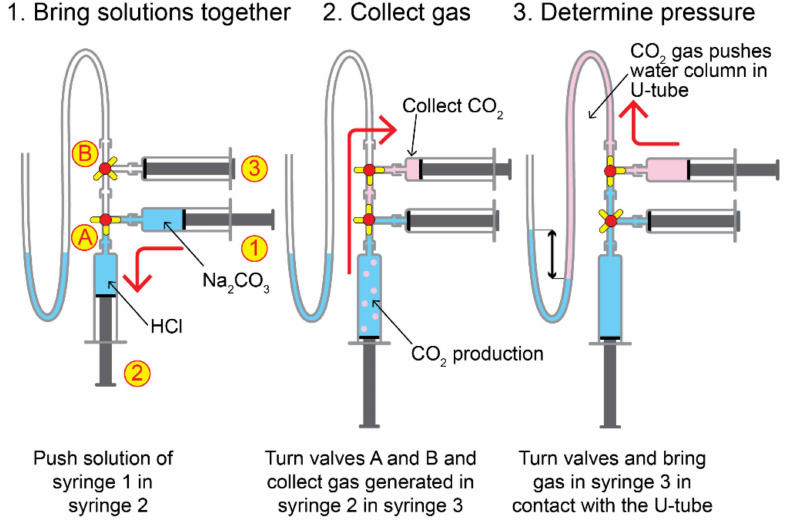
Figure 4. The three critical steps in the production process of CO 2 gas and the position of valves A and B for each